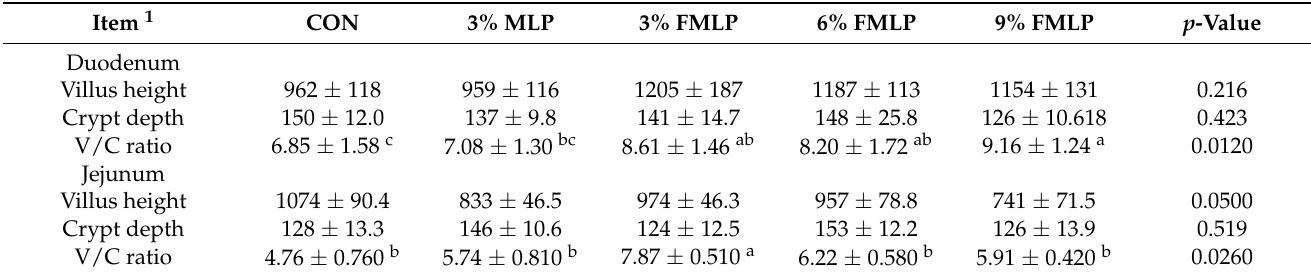
Table 6. Effects of FMLP on intestinal tissue histomorphology of